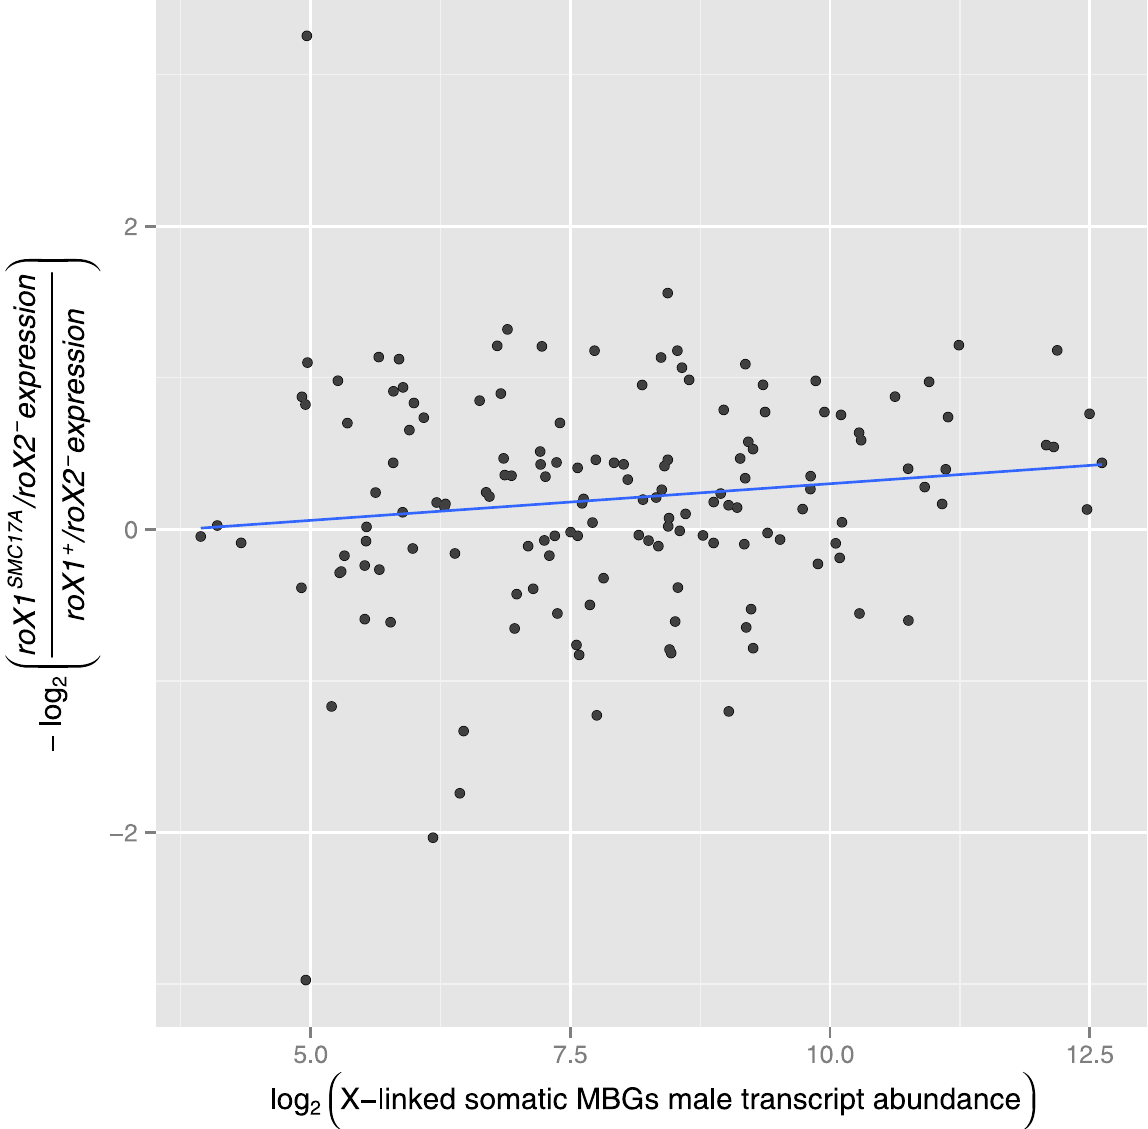
MBGs (Figure 2, dashed red line, r ~ 0 : 08, p § 0 : 05 ) or for testis- biased MBGs (Figure 2, dashed blue line, r ~ 0 : 04, p § 0 : 05 ). This